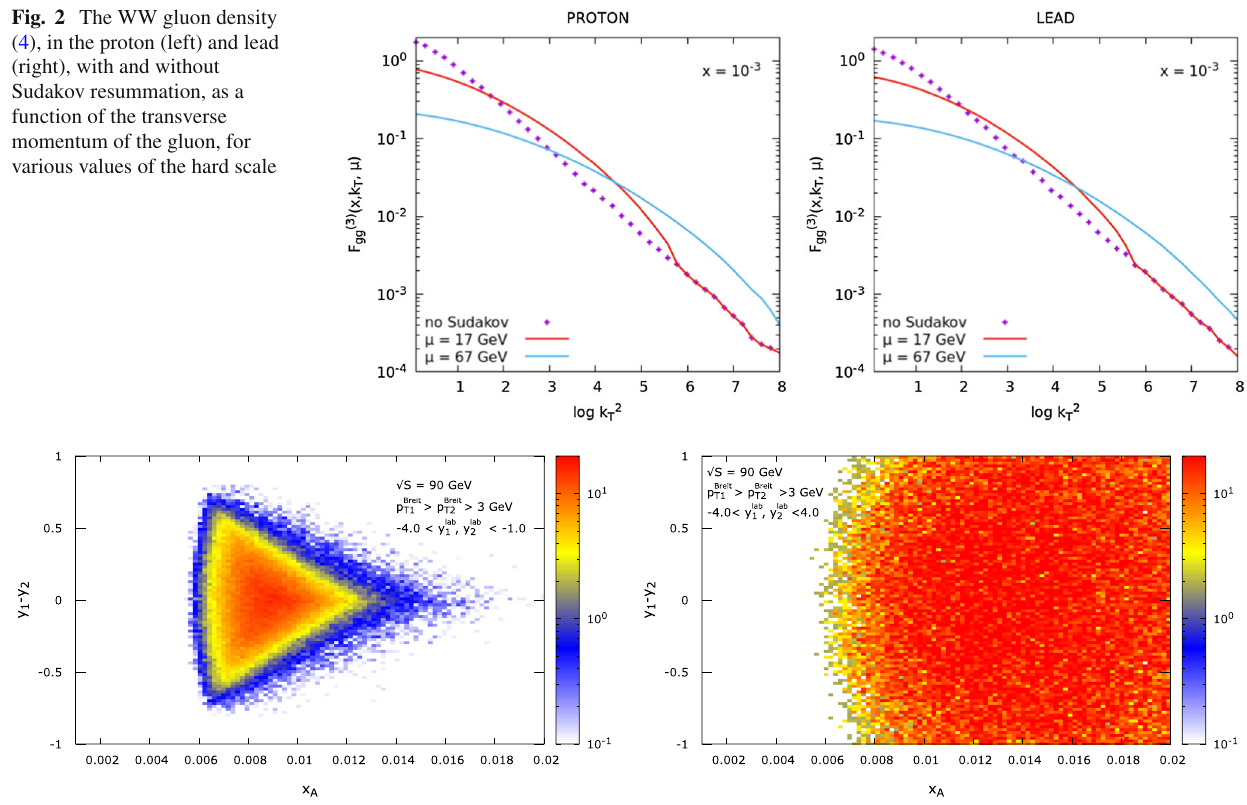
Fig. 3 Density plots representing contribution of events for a given gluon x and jet rapidity difference for the asymmetric rapidity cuts (left) and the symmetric rapidity cuts (right). The asymmetric rapidity cuts guarantee good focusing of the cross section around smaller values of x required by the